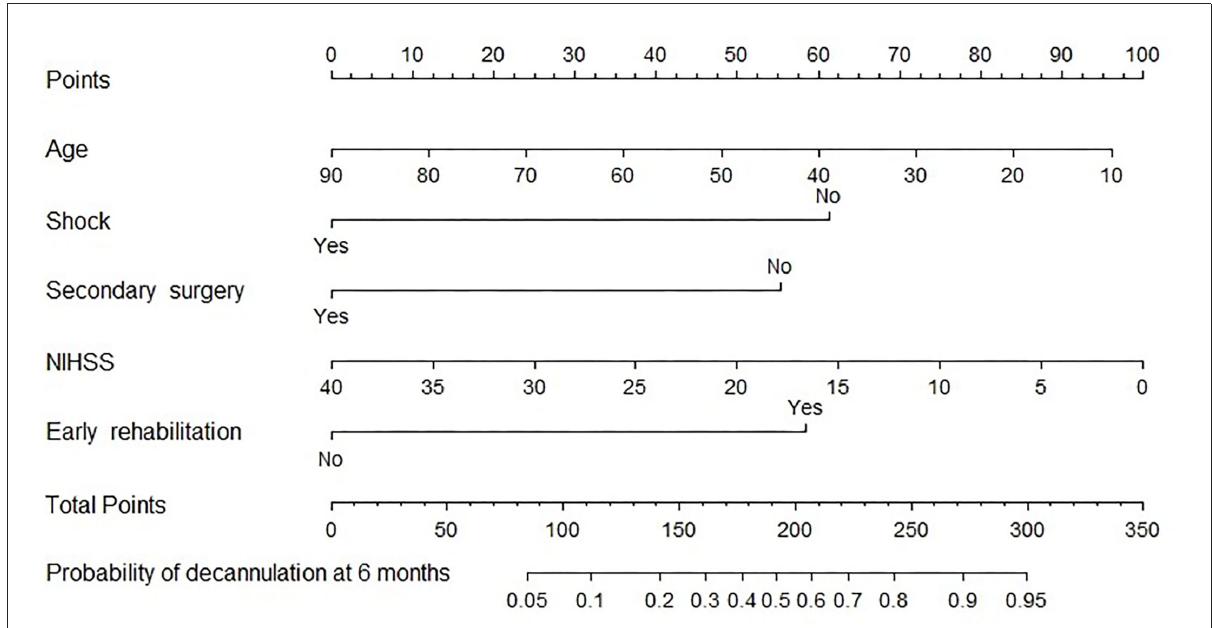
FIGURE2 Nomogram for predicting 6-month decannulation probability. To determine the probability of decannulation at 6-month, locate the patient’s age and draw a line straight up to the point’s axis to establish the score associated with age. Do this again for the other four covariates (shock, secondary surgery, NIHSS, and early rehabilitation), each time drawing a straight line upward toward the point’s axis. Add the scores for each covariate together and locate the total score on the total point’s axis. Draw a straight line down to the lowest line to find patient’s probability of decannulation at 6-month.